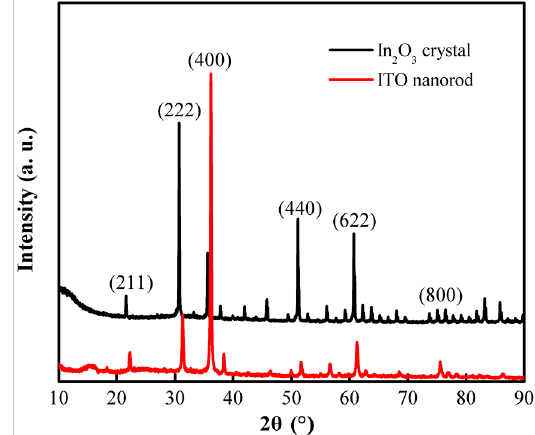
Figure 2. XRD patterns of In 2 O 3 cubic crystal and ITO single-crystalline rods grown at 300 °C. The diffraction peaks at 2 θ = 30.580°, 35.466°, 51.037° and 60.676° were assigned to the (222), (400), (440) and (622) reflections of cubic In 2 O 3 . Compared with that of the In 2 O 3 cubic crystal, the